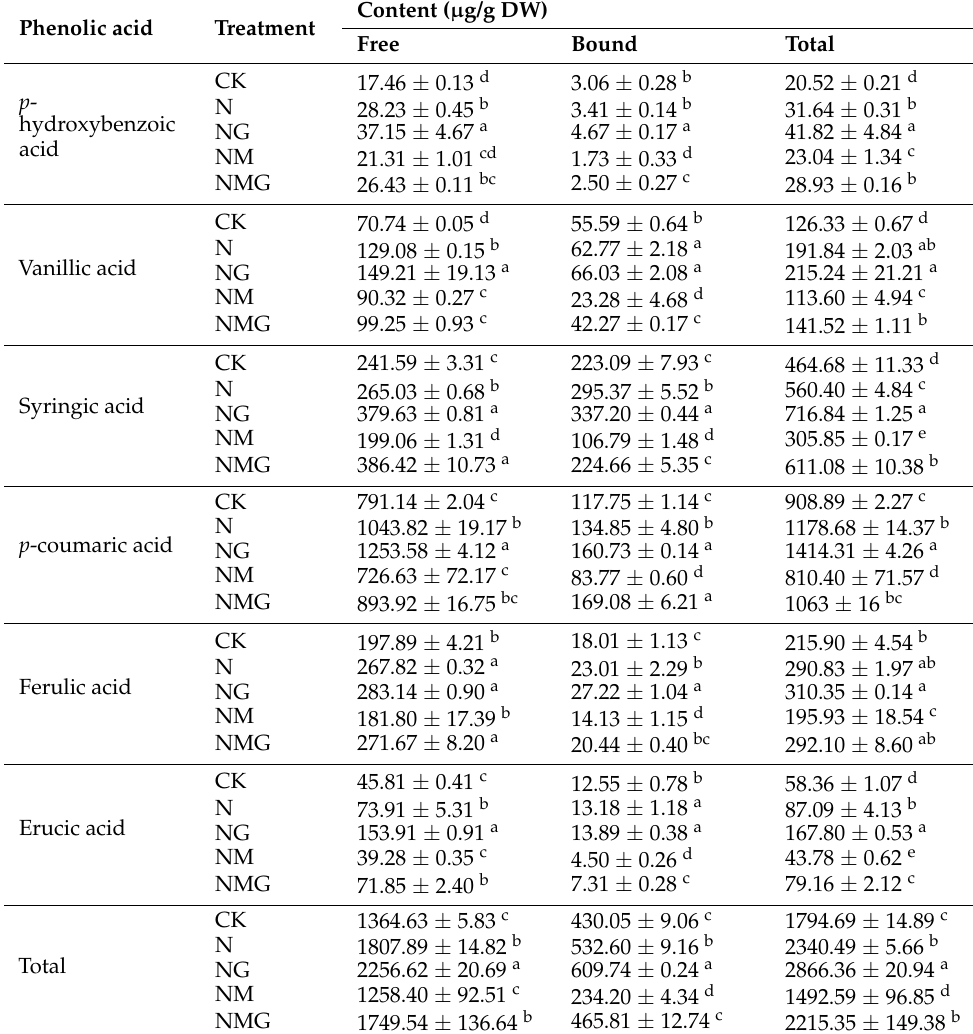
Table 2. Effects of GABA treatment on phenolic acids content in soybean sprouts under NaCl stress